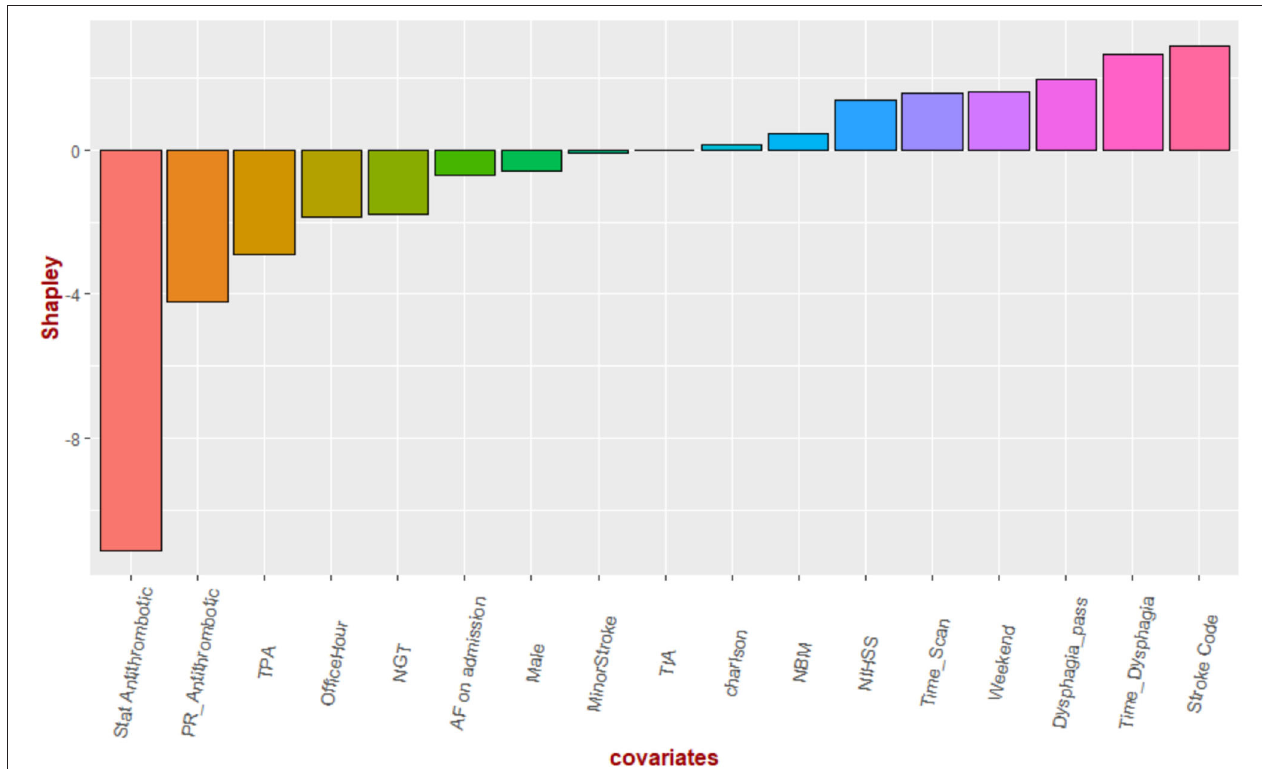
FIGURE 3 | Shapley values. The Shapley values denoting the direction of their effect on time to antithrombotics. Stat dose of antithrombotic had the greatest effect on shortening the time to antithrombotics while delay in dysphagia screen has the opposite effect.